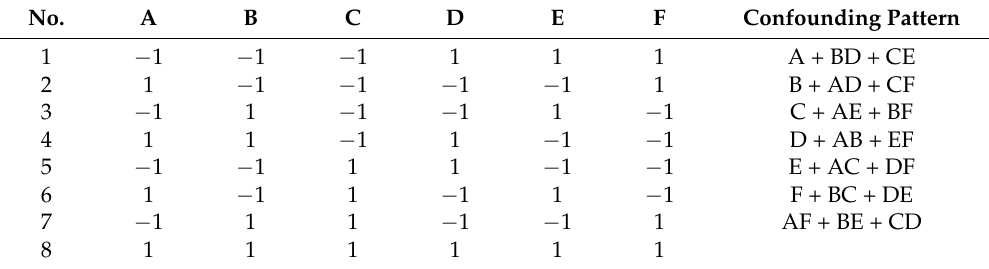
Table 3. Array of